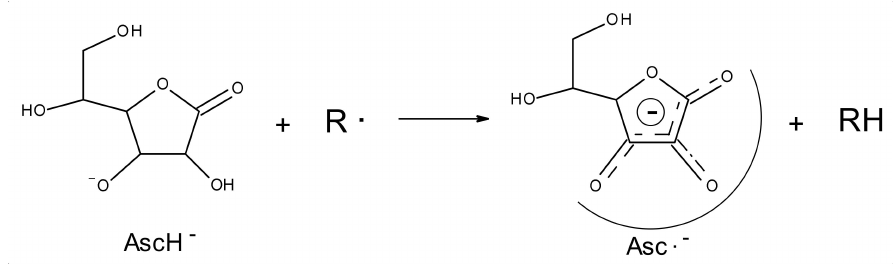
Figure 1. Conversion of the mono anion form of AA in Asc • by the transfer of an electron. The stability of the Asc • is due by the unpaired electron delocalized in the tricarboxylic ring.